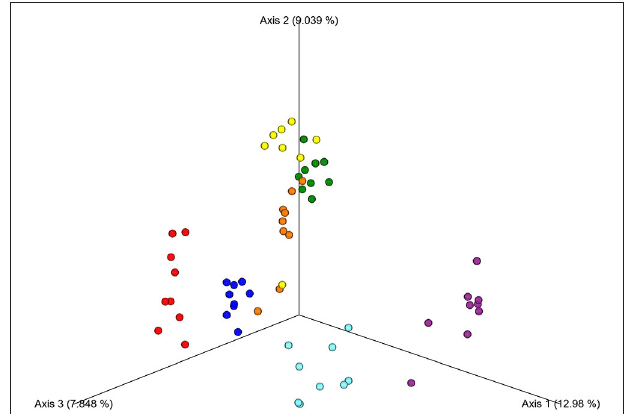
FIGURE 3 | Principal Coordinates Analysis (PCoA) of the fecal samples showing the distance among the seven individual horses. The analysis was based on the weighted UniFrac metric. Different colors represent respective individual